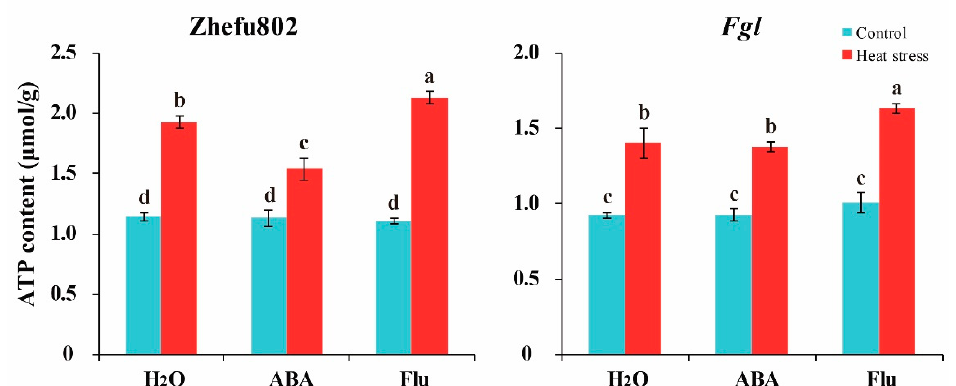
Figure 5. The effects of exogenously applied ABA on ATP content of rice plants under heat stress. ABA, abscisic acid. Flu, the ABA synthase inhibitor fluridone. Error bars denote standard deviations ( n = 3). Different letters indicate significant differences between the control and heat stress treatments within a genotype by two-way analysis of variance (temperature and treatment) ( p < 0.05).